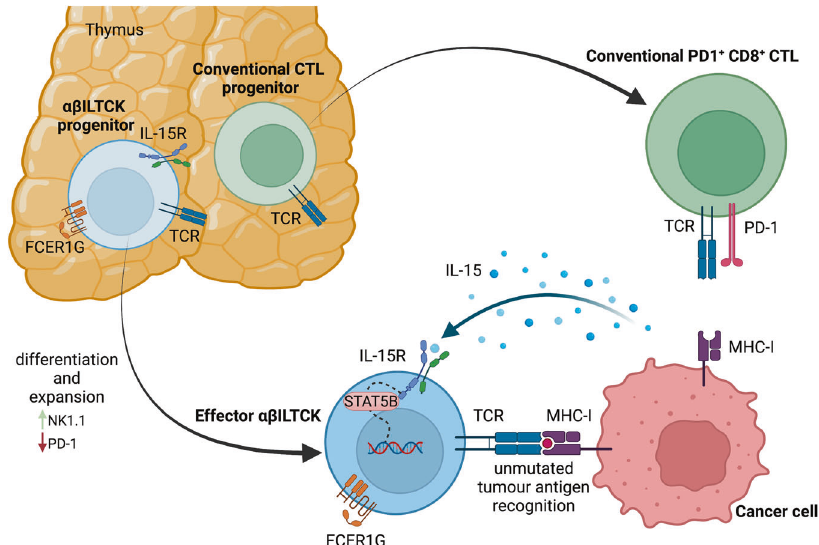
Fig. 1 Activation of thymus derived cytotoxic FCER1G + αβ ILTCKs in cancer tissue. FCER1G-expressing αβ TCR lineage innate-like T cells with high cytotoxic potential ( αβ ILTCKs) are an evolutionarily conserved innate-type T cell that develops from a unique thymic progenitor. These FCER1G + αβ ILTCKs are distinct from conventional PD-1 + CD8 + cytotoxic T cells (CTLs) and reactive to unmutated self (tumour) antigen. Their intratumoural recruitment, local expansion and effector function is driven by tumour-elicited IL-15 production. For details see text. IL-15R IL-15 receptor, FCER1G Fc Epsilon Receptor Ig, TCR T cell receptor, MHC-I major histocompatibility complex class I. Created with